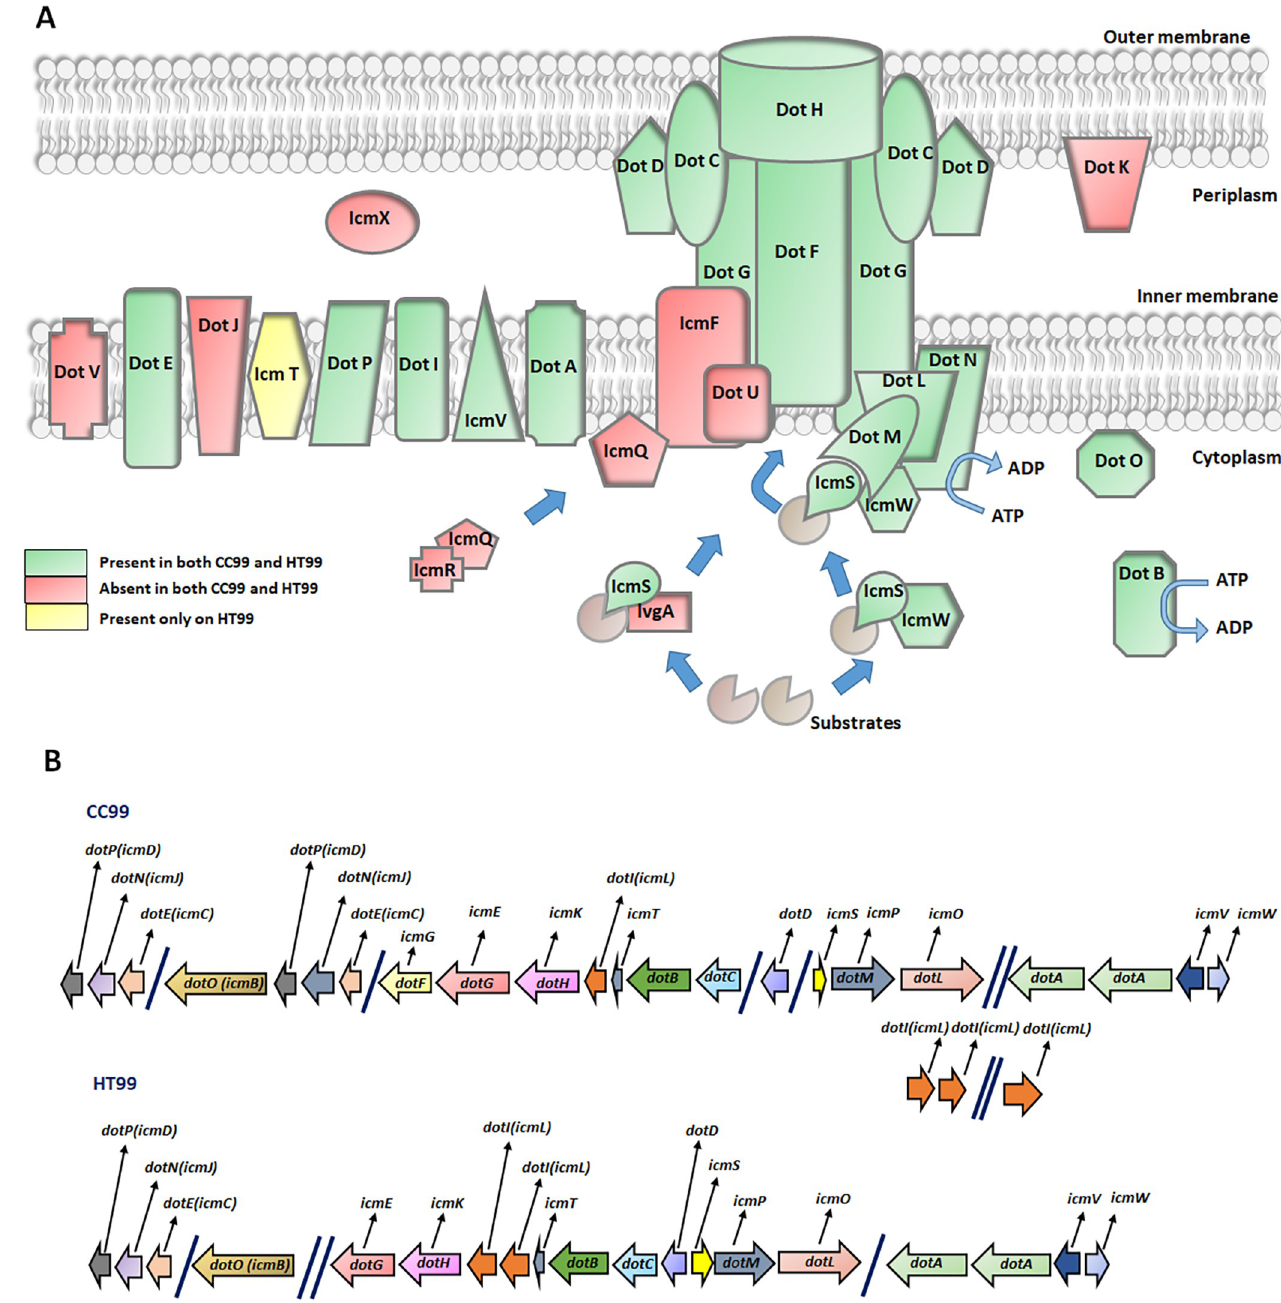
Fig 6. Dot/icm T4SS in “ Ca . B. cookevillensis” (CC99) and “ Ca . B. aquae” (HT99) with comparisons to C . burnetii and L . pneumophila . (A) Presumed location and topological relationships of dot/icm proteins. Figure adapted from [77]. (B) Genomic organization of the genes encoding dot/icm proteins in CC99 and HT99. Genes dotC , dotD , dotF/icmG , dotG/icmE and dotH/icmK encode the core proteins of the complex. Genes icmS and icmW encode components involved substrate recognition and secretion. Both bacteria are missing the gene encoding LvgA, a protein identified as a potential fifth chaperone to IcmS. Genes dotA , dotE , dotI , dotP and icmV which encode the inner membrane proteins are also present in both bacteria. Genes dotI and dotJ (absent in both bacteria) encode for an integral inner membrane protein. Genes dotL , dotM and dotN encode membrane proteins components involved in recruitment of effector proteins. Genes dotB and dotO encode cytoplasmic ATPase complex proteins. Genes dotV and dotJ (encoding inner membrane proteins); icmQ (encoding a pore-forming cytoplasmic protein) and icmR (encoding a chaperone for IcmQ) are absent in both bacteria.